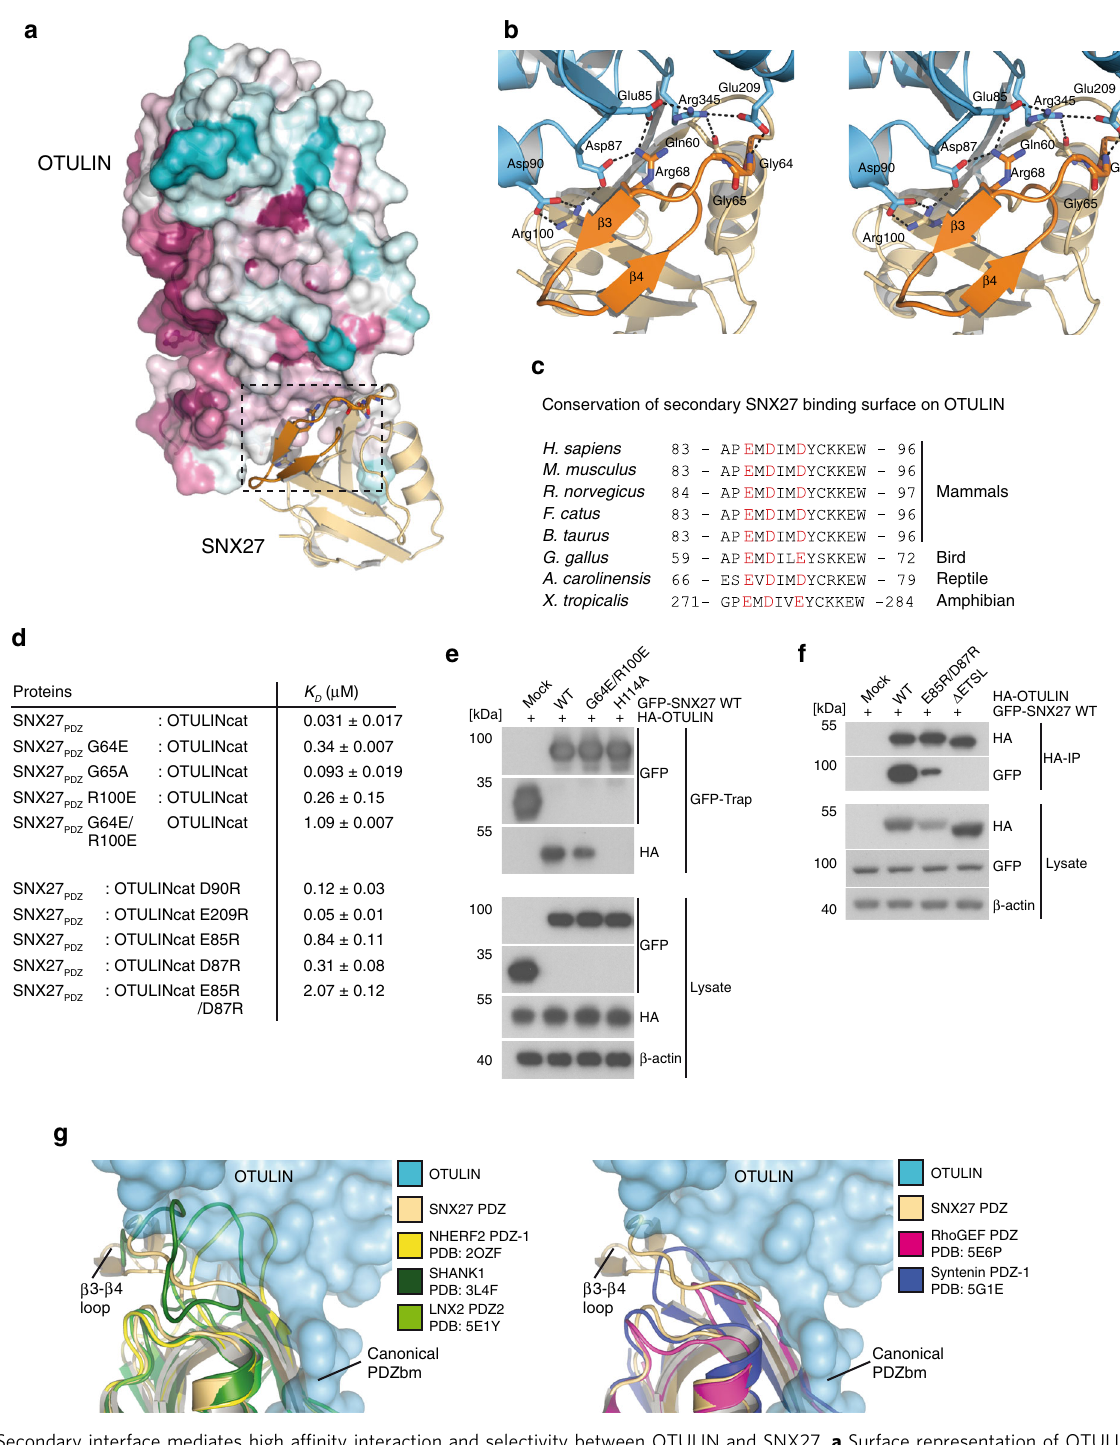
Fig. 4 Secondary interface mediates high af fi nity interaction and selectivity between OTULIN and SNX27. a Surface representation of OTULIN colored based upon conservation calculated through the Consurf webserver. Box encloses the second SNX27 interface. b Close-up stereo view of the second interface of OTULIN from a . The unique β 3 – β 4 hairpin insertion within the SNX27 PDZ domain is shown in orange. Hydrogen bonds between residues are shown with dotted lines. c Sequence alignment and conservation of second SNX27 binding surface in OTULIN orthologues from tetrapod animals. Conserved polar and electrostatic amino acids involved in binding to SNX27 are depicted in red. d Summary of SNX27 – OTULIN af fi nities ( K D ) determined by ITC for mutations in the secondary interface. e HEK293 cells were co-transfected with HA-OTULIN and GFP-SNX27 WT or mutants that carry missense mutations in the canonical cargo binding site (H114A) or in the second OTULIN interface (G64E/R100E). Binding was analyzed after GFP-Traps by WB. f HEK293 cells were co-transfected with GFP-SNX27 and HA-OTULIN constructs. OTULIN mutants either lack the C-terminal PDZbm ( Δ ETSL) or carry missense mutations in the second SNX27 interface (E85R/D87R). SNX27 binding was analyzed after HA-IP by WB. g Superimposition of structurally related PDZ domains onto SNX27 – OTULIN structure. All closely related PDZ domains lack the SNX27 β 3- β 4 hairpin insertion. PDZ domains of SHANK1, NHERF1, and LNX2 contain a larger insertion that may clash with the second interface on OTULIN (left). PDZs of RhoGEF and Syntenin1 contain a short loop at the equivalent position that would not clash with the second interface of OTULIN (right). Source data are provided as a Source Data fi